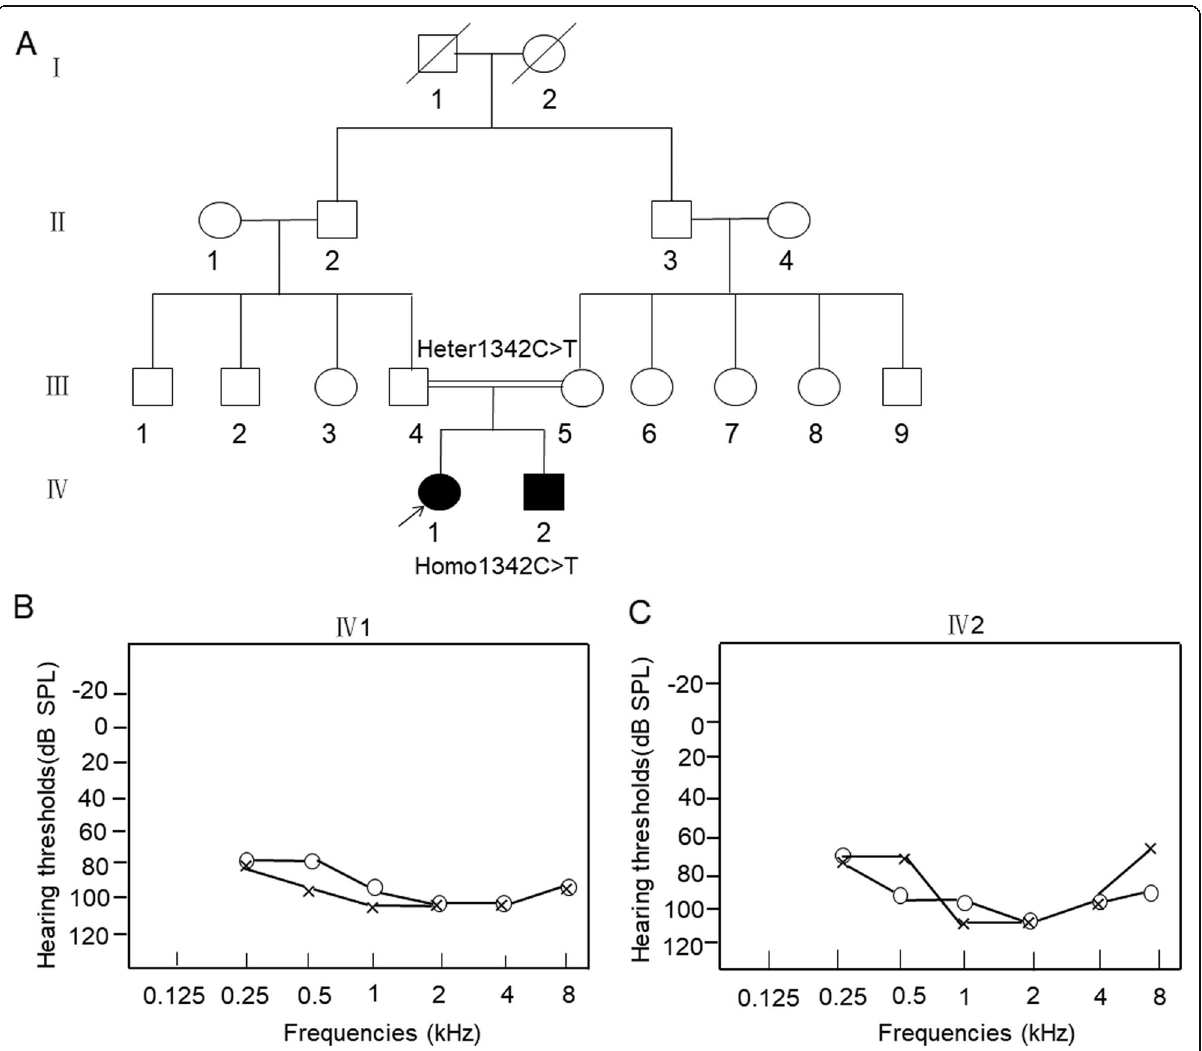
Fig. 1 Identification of the individuals with hearing impairment. a . Pedigree analyses to identify the family members with hearing loss. The proband is indicated by an arrow. Genotypes are indicated as heterozygous 1342C> T (Heter1342C > T) for III34 and III45, and homozygous 1342C> T (Homo1342C > T) for (IV1 and IV2). b . Pure-tone audiograms to identify the hearing affected individuals. The individuals (IV1 and IV2) show severe to profound symmetric hearing